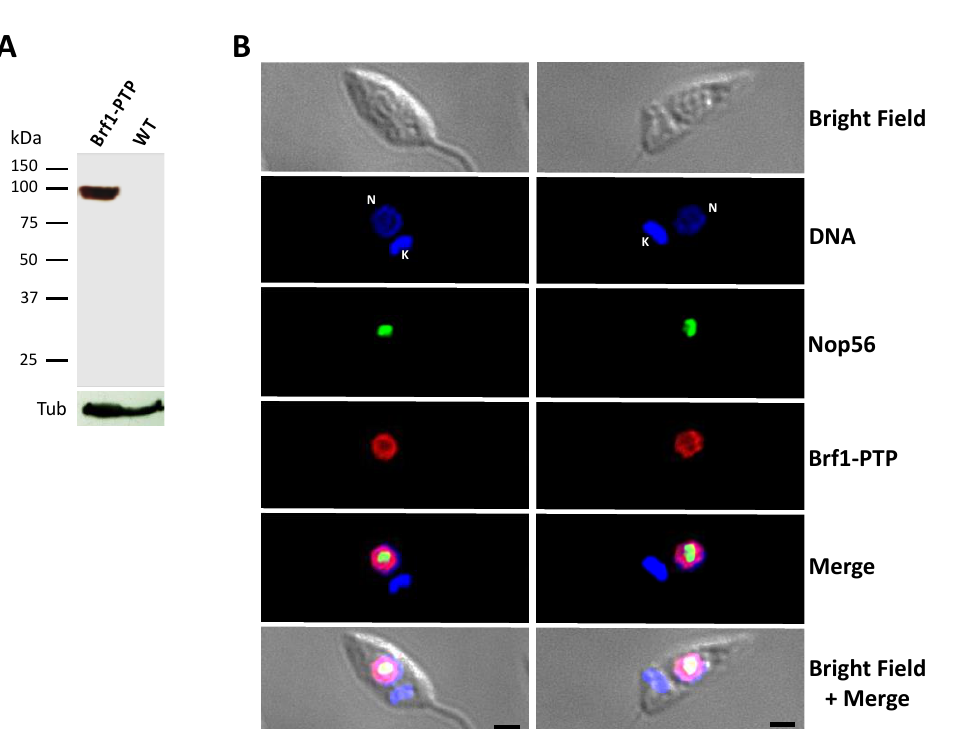
Figure 2. LmBrf1 is a nuclear protein. ( A ) Western blot analysis with cells that express the recombinant protein LmBrf1-PTP (Brf1-PTP (Prot C-TEV-Prot A)) and wild-type cells (WT). Membranes were incubated with an antibody against Prot C, which recognizes the PTP tag. As a loading control, a human α / β -tubulin antibody was used. ( B ) PTP-tagged LmBrf1 was detected by immunofluorescence with a rabbit anti-Prot C polyclonal antibody and an anti-rabbit immunoglobulin G (IgG) coupled with Alexa Fluor 568 (red). Nop56 was detected with a mouse anti-Nop56 antibody and an anti-mouse IgG secondary antibody conjugated with Alexa Fluor 488 (green). Nuclei (N) and kinetoplast (K) DNA were stained with 4’,6-diamidino-2-phenylindole (DAPI; blue). Scale bar indicates 2 µ m.